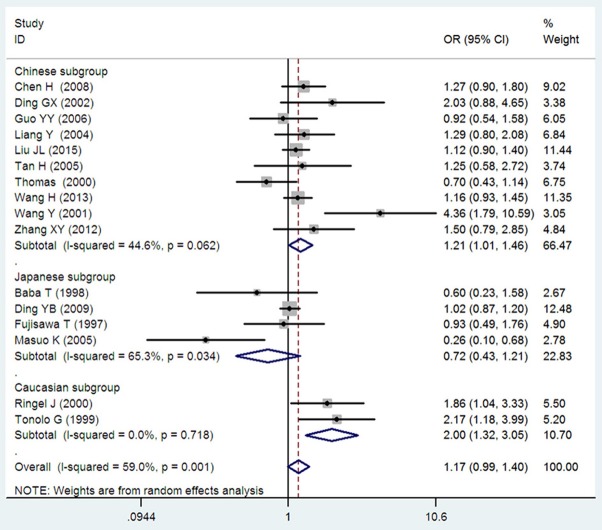
Forest plot of EH associated with ADRB3 gene Trp64Arg polymorphism under a dominant genetic model (AA+TA vs. TT).